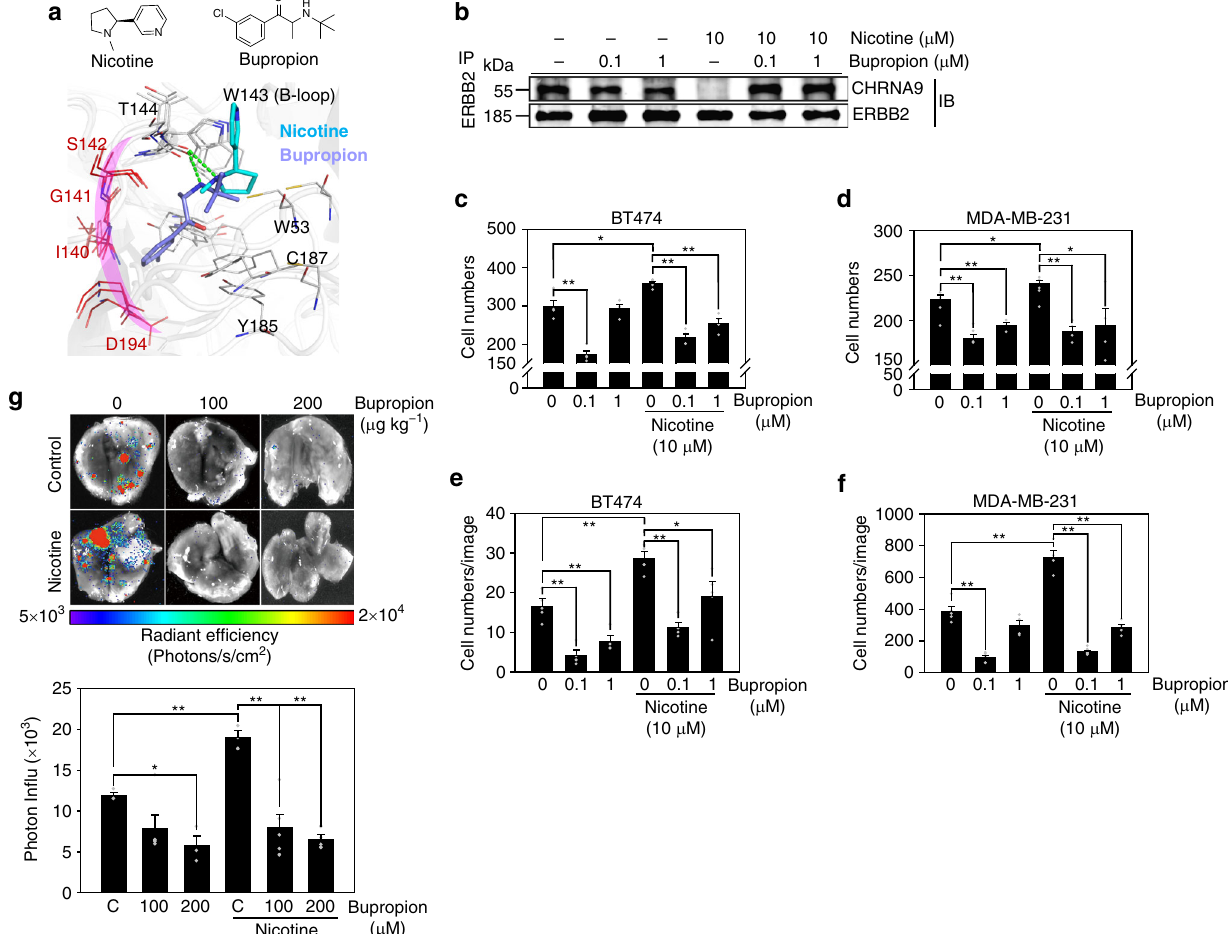
Fig. 7 Bupropion as a repurposed drug for anti-metastasis in breast cancer. a Binding model between nicotinic acetylcholine receptor subunit α 9 (CHRNA9), bupropion, and nicotine. Compared with nicotine, the 1-(3-chlorophenyl)propan-1-one bupropion moiety can bind an additional subpocket comprising several CHRNA9 contact residues (e.g., I140, G141, S142, and D194). b Bupropion as an inhibitor attenuating nicotine-induced CHRNA9/ERBB2 dissociation, as detected by an immunoprecipitation (IP) assay. BT474 cells exposed with or without 10 μ M nicotine were subjected to bupropion pretreatment at 0, 0.1, and 1 μ M. An ERBB2 antibody/bead complex was precipitated and immunoblotted for a CHRNA9 antibody, and an ERBB2 blotting was used as the loading control. Bupropion as a repurposed drug not only inhibits the c , d migration and e , f invasion abilities of BT474 (24 and 72 h) and MDA-MB-231 (12 and 48 h) cells, and g the metastasis ability of a spontaneous pulmonary metastasis mouse model but also attenuates the nicotine- induced effects. In invasion and migration assays, the cells were either treated with or without nicotine (10 µ M). All mice were randomized into six groups ( n = 5 per group) and intraperitoneally injected with phosphate-buffered saline, 100 or 200 µ g kg − 1 bupropion three times per week, and with or without nicotine treatment (10 μ g ml − 1 ) via their drinking water. After 2 months, the mice were sacri fi ced, and their lung tissues were measured for metastasis by bioluminescence imaging. The color bar indicates a signal gradient from high (red) to low bioluminescence intensity (blue). The error bars indicate the mean ± standard error. Data were analyzed with Student ’ s t tests; all P values were two-sided. P values <0.05 and <0.01 are indicated by an asterisk and double asterisk, respectively. Source data are provided as a Source Data fi